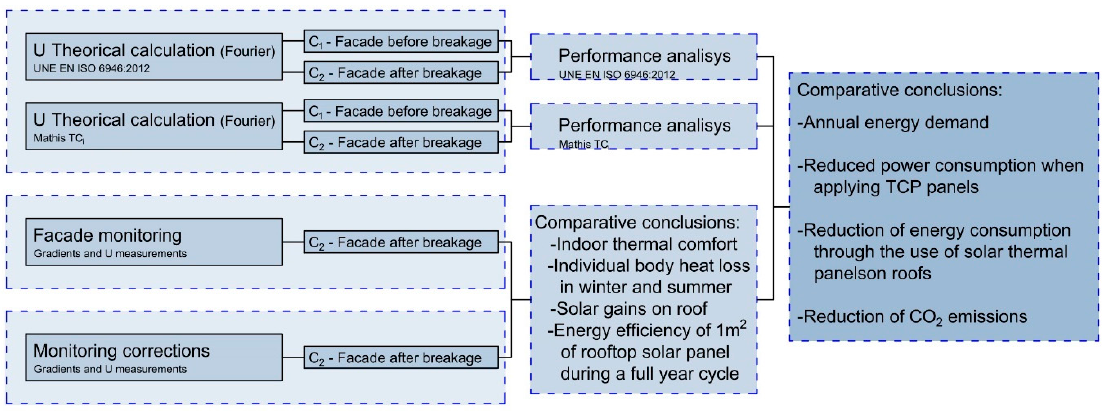
Figure 3. The flow diagram of the methodology followed in the study.